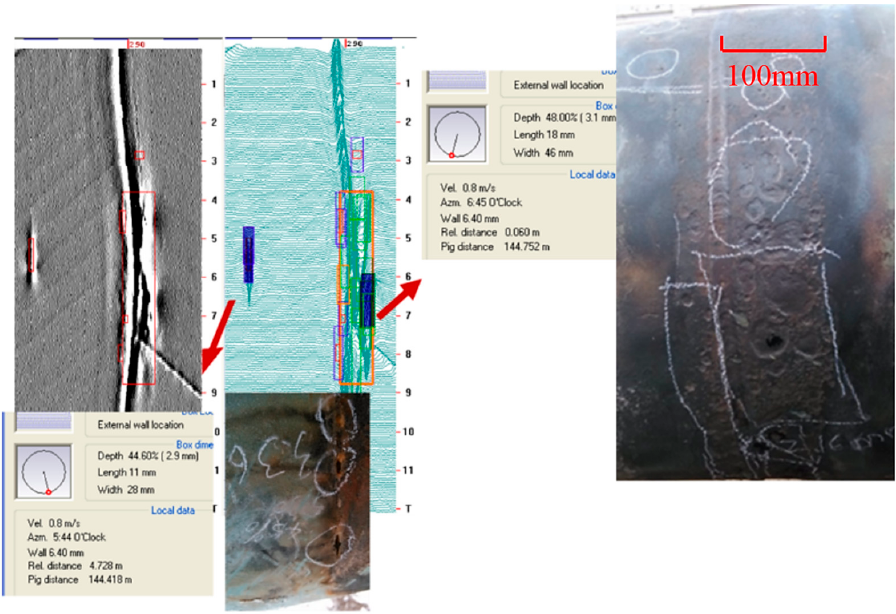
Figure 9. Typical signals and excavation pictures for corrosion.